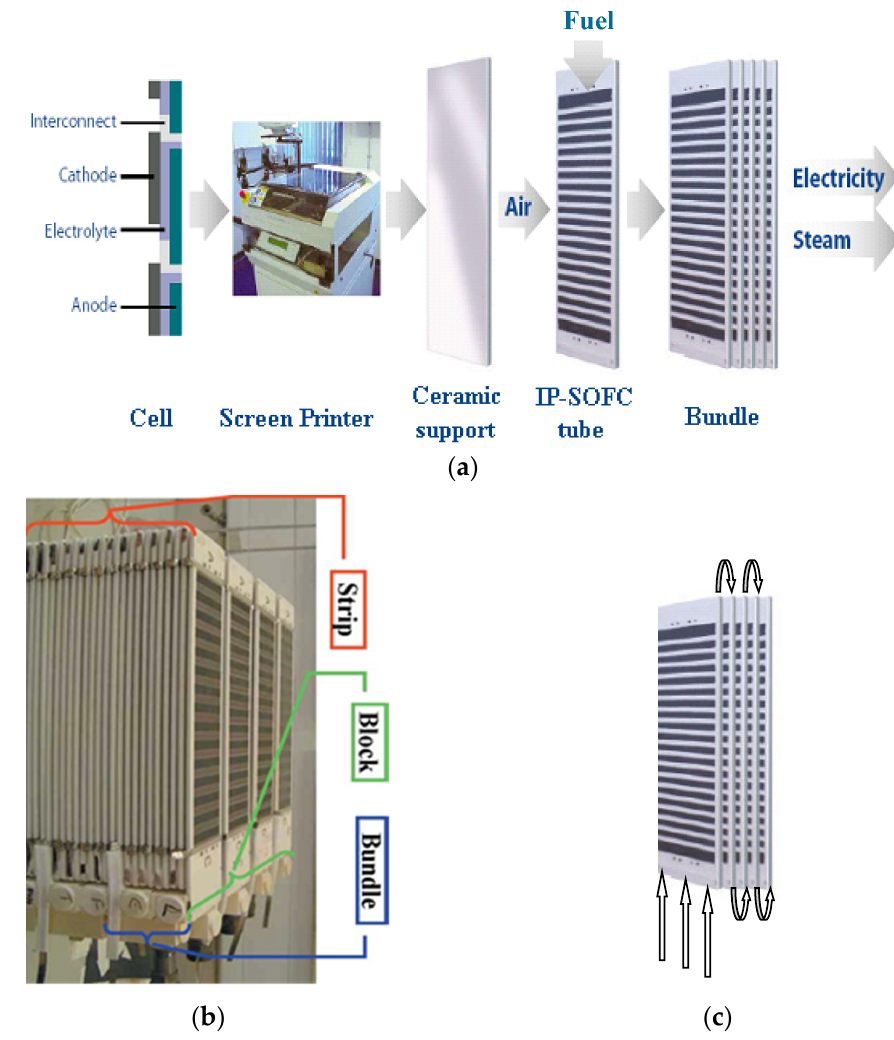
Figure 2. ( a ) IP ‐ SOFC scale ‐ up: single cell, planar tube and bundle; ( b ) IP ‐ SOFC bundle as the basic repeat unit of the experimental strip and block; ( c ) fuel flow scheme in the IP ‐ SOFC bundle.